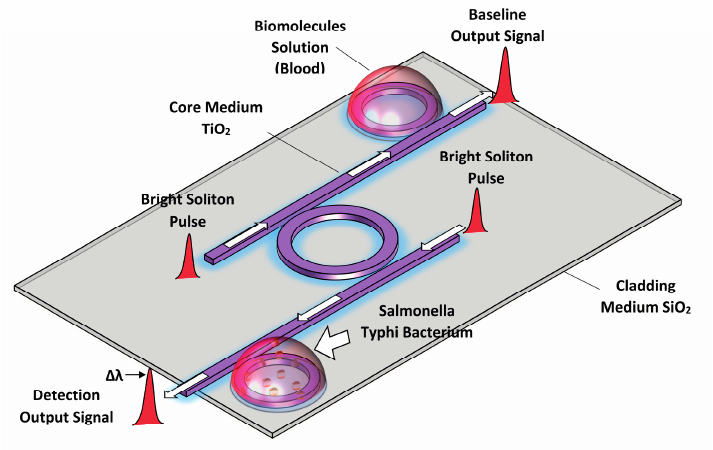
Figure 2. Diagram of biosensor consist of DR-ADF microring resonator within biomolecules